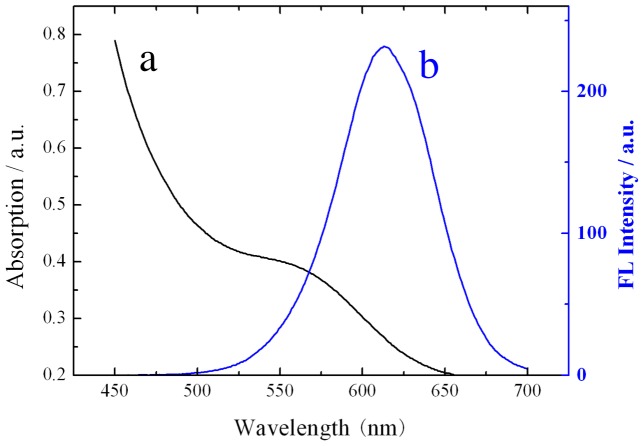
Absorption and fluorescence spectra of thiol-capped CdTe QDs in aqueous solution.